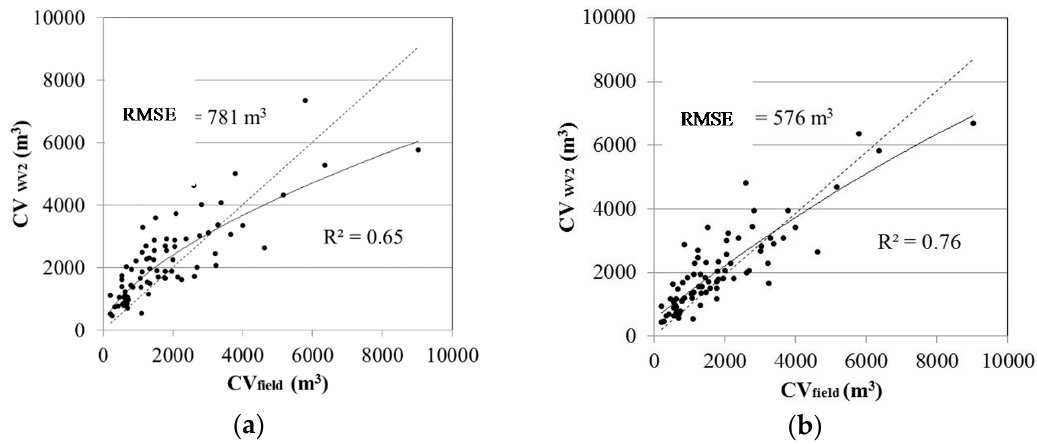
Figure 9. Scatterplots of canopy volume from WV2 using ( a ) crown projected area (CA); and ( b ) crown diameter (CD) with crown volume (CV) as the predictor variable from field measurements. The dashed lines are the 1:1 equivalence between measured and predicted values and the solid lines the best-fit regression curves (power and polynomial, respectively).